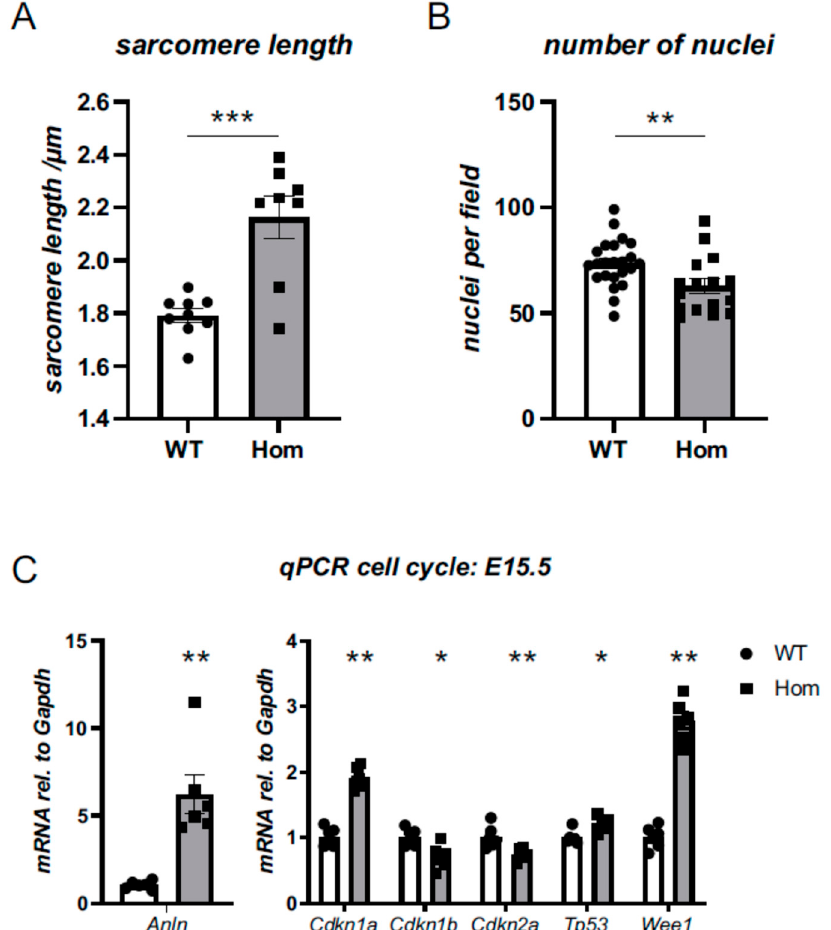
Figure 4. Measurement of cardiomyocyte sarcomere and nuclei parameters reveals alterations in Hom hearts. Wholemount stainings (see Figure 3A) for alpha-actinin, phalloidin (F-actin) and DAPI were analysed. ( A ) Hom hearts display increased mean sarcomere length. Each data point represents the average sarcomere length for one heart, with a total of 55 images from 9 WT hearts and 41 images from 8 Hom hearts analysed; nested ANOVA, *** p < 0.001. ( B ) Hom hearts have fewer nuclei. Each data point represents the average value for one heart, with a total of 112 images from 23 WT hearts and 79 images from 16 Hom hearts analysed; nested ANOVA, ** p < 0.01. For a wider range of nuclear parameters being analysed, see Table S5. ( C ) Targeted assessment of transcriptional changes by qPCR in WT and Hom E15.5 for cell-cycle markers. All measurements are normalised to Gapdh . Significant changes are observed in the hearts of Hom mice for all transcripts investigated (Student’s t -test, n = 6 per group, * p < 0.05, ** p <